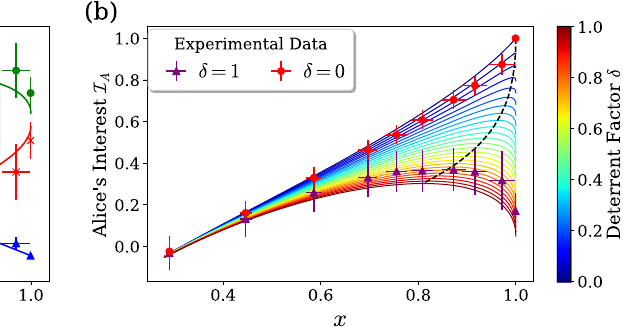
Fig. 6 | Results for a dishonest Alice who sets different values of x than the honestvalue. Thelinesshowtheoreticalpredictions,calculatedfromEqs.(13)-(16), withef fi cienciesgiveninTable1.Theerrorbarsaremainlyduetoerrorpropagation